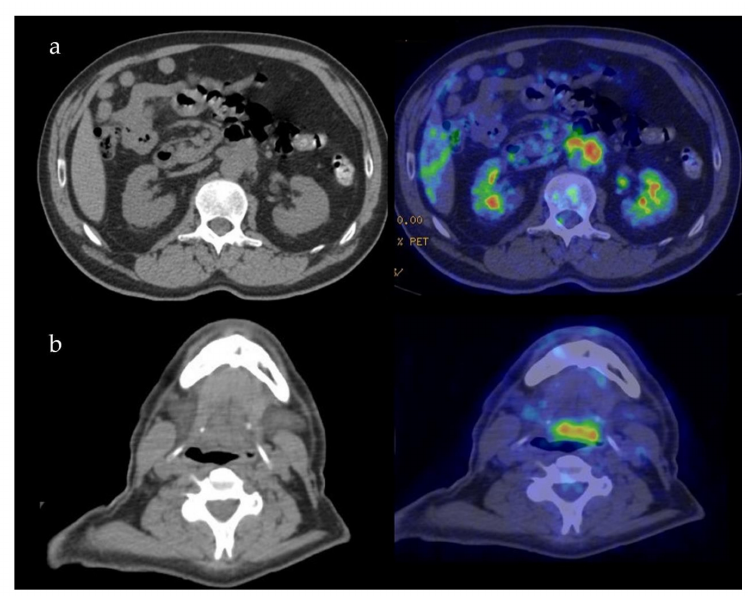
Figure 4. Patient 5: PET-CT findings of the retroperitoneum ( a ) and oropharynx ( b ).